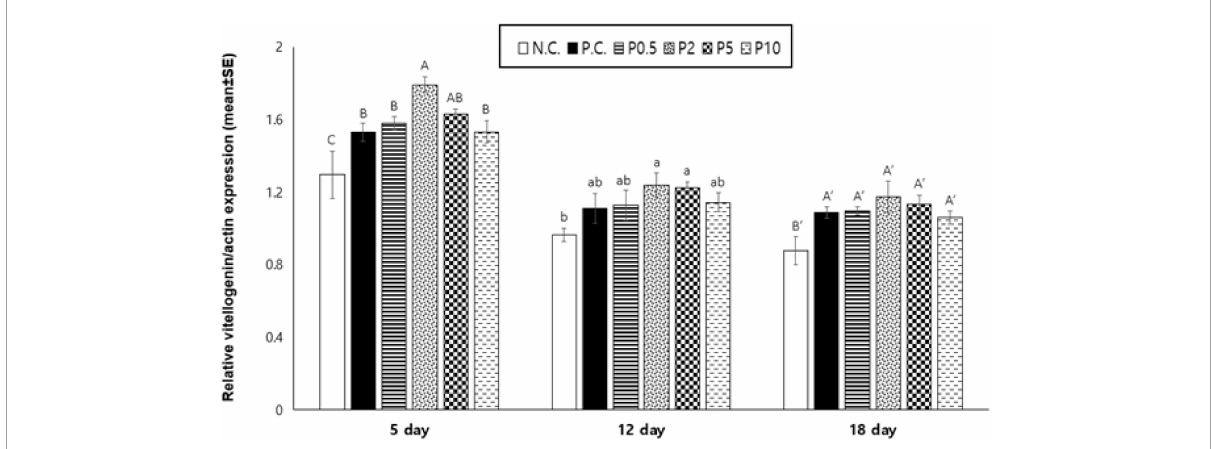
FIGURE7 Relative vitellogenin expression/actin (mean ± SE) measured on days 5, 12, and 18 in caged honey bees fed with different diets. NC means negative control; PC means positive control. Different letters over the bar indicate statistically significant differences ( p < 0.05).